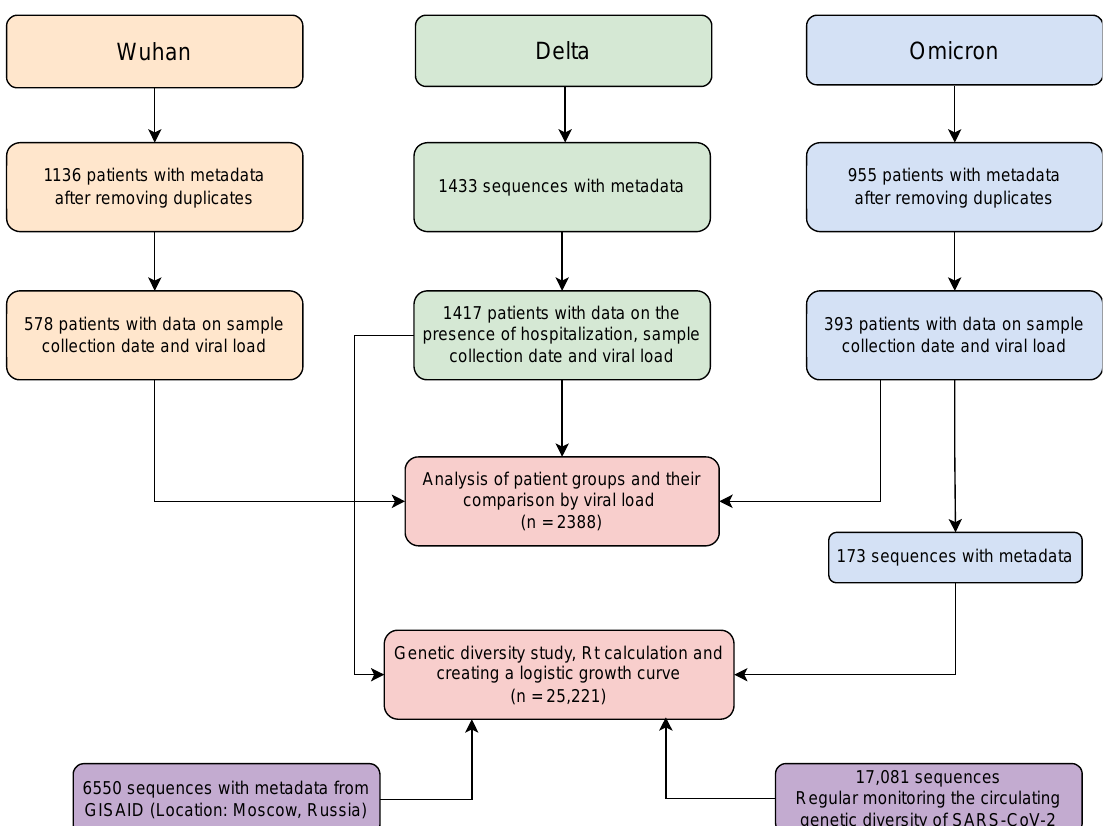
Figure 1. Database in preparation for the analysis.